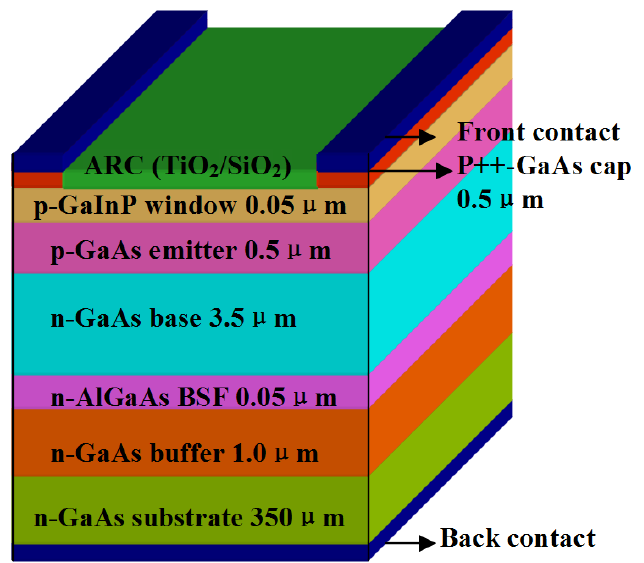
Figure 7. Structure of GaAs PV converter.